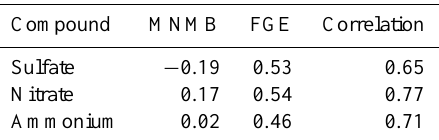
Table 7. Statistics of daily observations at the same Irish station as in Fig. 7 against RACMSIA simulation. The parameter sulfate corresponds to corrected